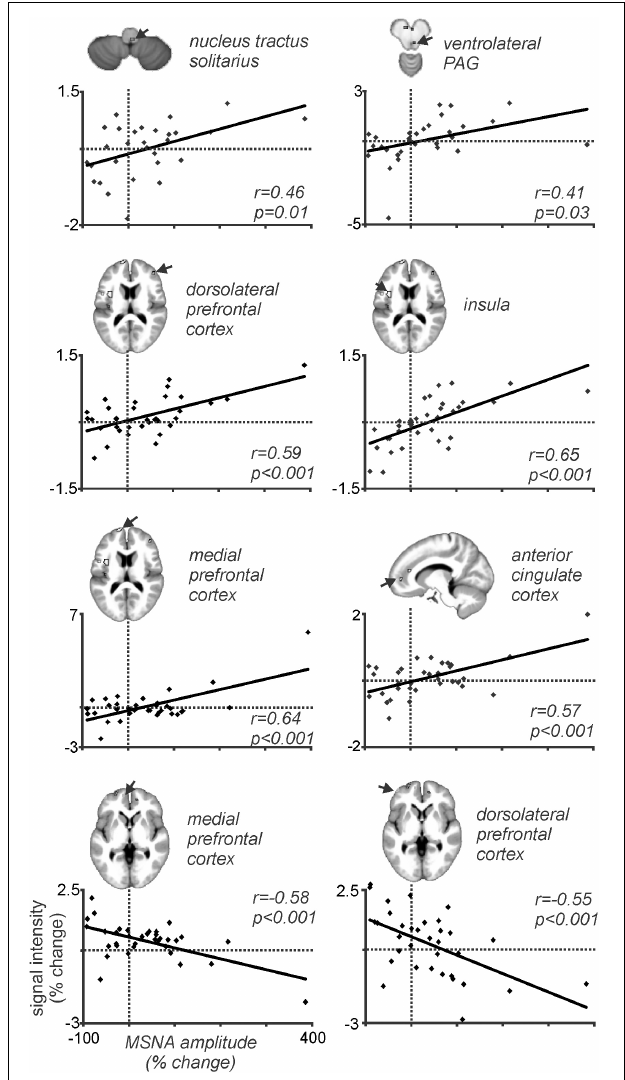
FIGURE 7 | Plots of MSNA-coupled BOLD signal intensity during tonic pain in all 37 participants. In all regions there is a significant linear relationship between the change in BOLD signal intensity and the change in burst amplitude of MSNA. Reproduced, with permission, from Kobuch et al. (2018).